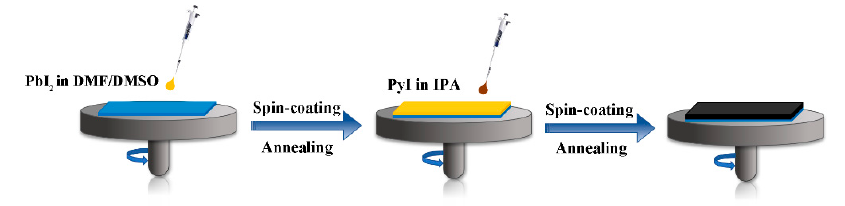
Figure 1. Schematic illustration of the fabrication of PyPbI 3 film.